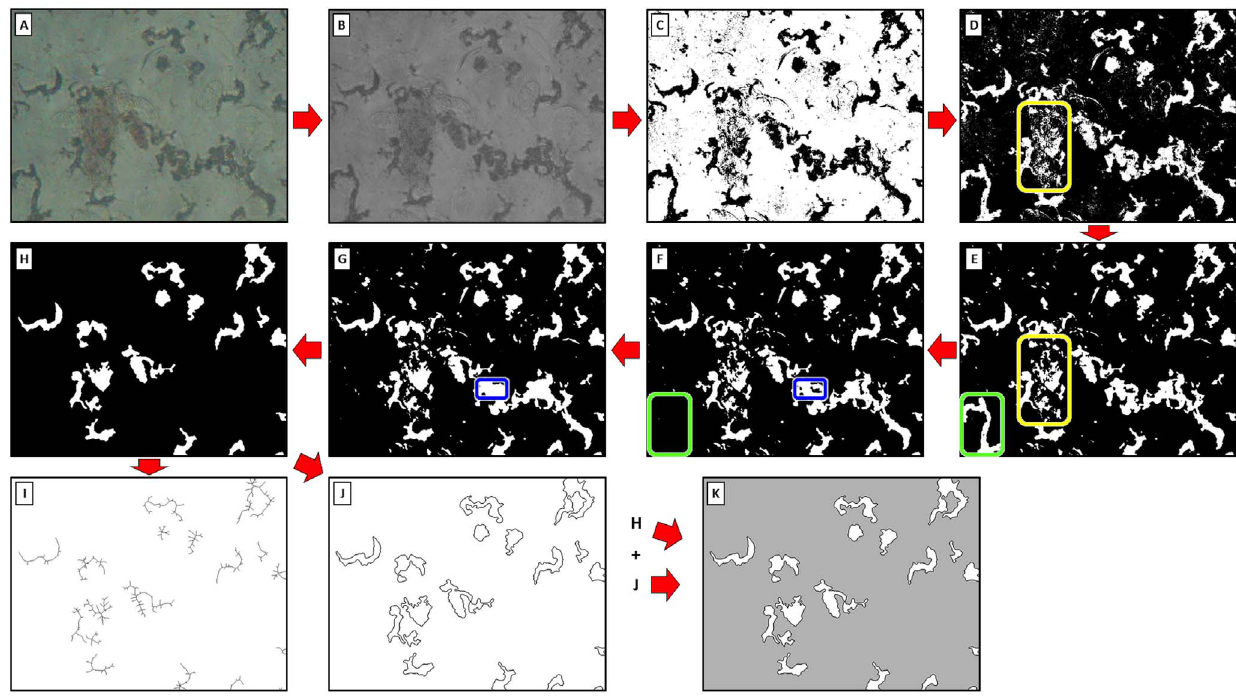
Figure 4. Steps of image processing of a MODS-culture photo. (A) Original photo. (B) Conversion to gray scale, obtaining the ‘Gray scale image’. (C) Global binarization, transforming all the pixels in black (0) or white (1). (D) Black-white inversion. (E) Border smoothing, to reduce the ‘noise’. The yellow rectangle in figures D (before) and E (after) shows the changes produced by this process. (F) Exclusion of boundary objects, deleting the objects in the border of the photo. The green rectangle in figures E (before) and F (after) shows the changes produced by this process. (G) Holes Filtering, removing black objects inside white objects. The blue rectangle in figures F (before) and G (after) shows the changes produced by this process. (H) Area filtering, dropping the outsider values in the distribution of area values, obtaining the ‘Cleaned image’. (I) Skeletonization, obtaining the ‘SKL values’. (J) Identification of object borders, obtaining the ‘Borders image’. (K) Image recoloring: The black pixels in figure H are converted to gray, and this picture is superposed by the figure J, giving the ‘Tri-colored image’. Figures (B), (I) and (K) are used for the features extraction process.